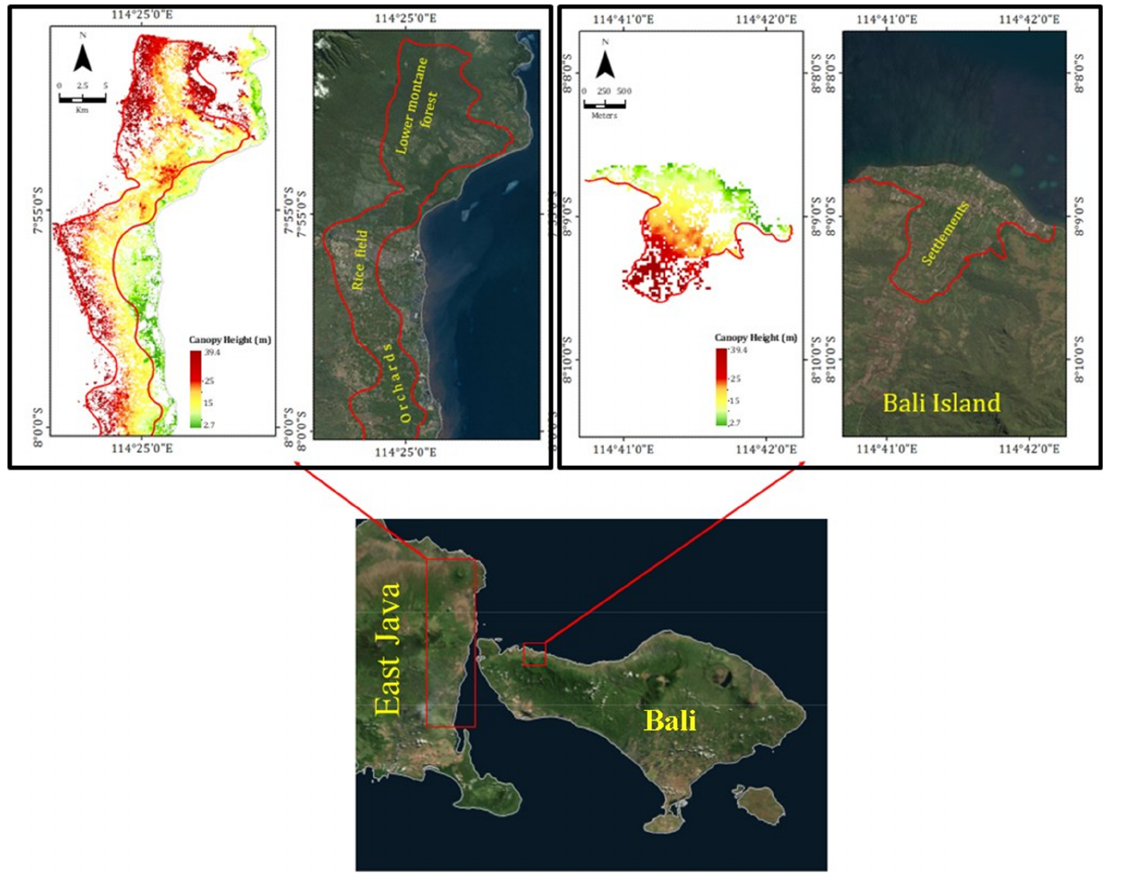
Figure 5. Two examples of type-B inaccuracy are shown. A valley on the northwest coast of Bali is shown on the top right. Another area along the east coast of East Java is shown on the top left. In each case, the mangrove height maps are shown on the left, and the Google Earth images of the respective areas are shown on the right. The demarcated vegetation in both areas was non-mangrove but was included in the maps of Giri et al. [9] and Hamilton and Casey [7]. Our height-based method could not identify these areas where canopies are <40 m tall, so these areas remain as inaccuracies in our global mangrove height maps.